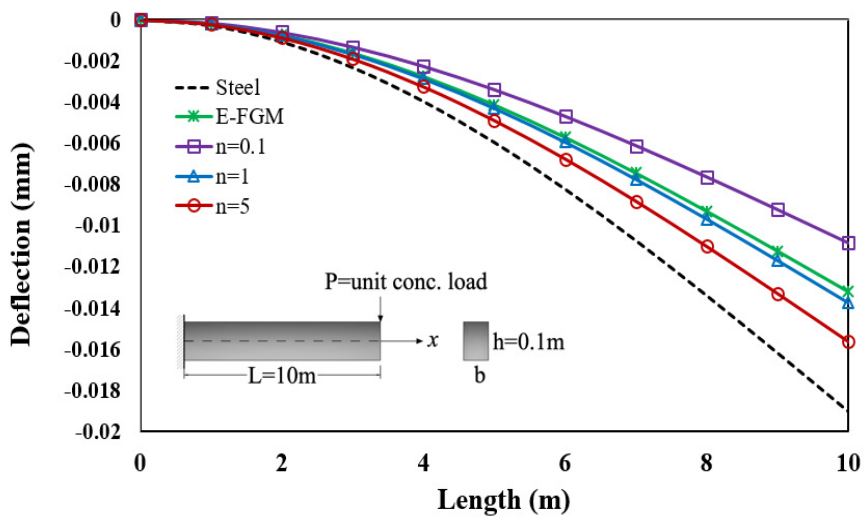
Figure 10. Deflection of cantilever FGM